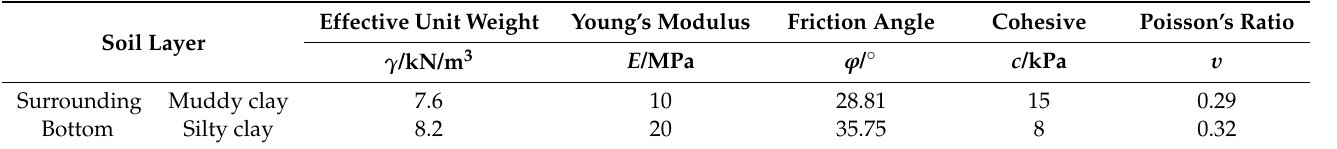
Table 2. Physical parameters of the soil.